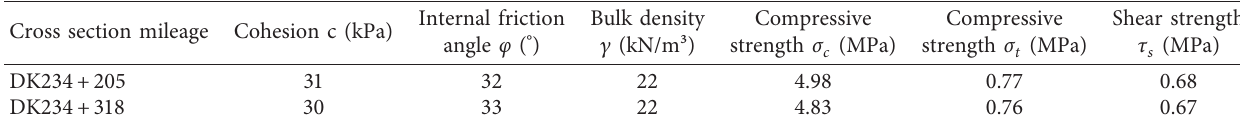
Table 4: Relevant mechanical parameters of surrounding rock.